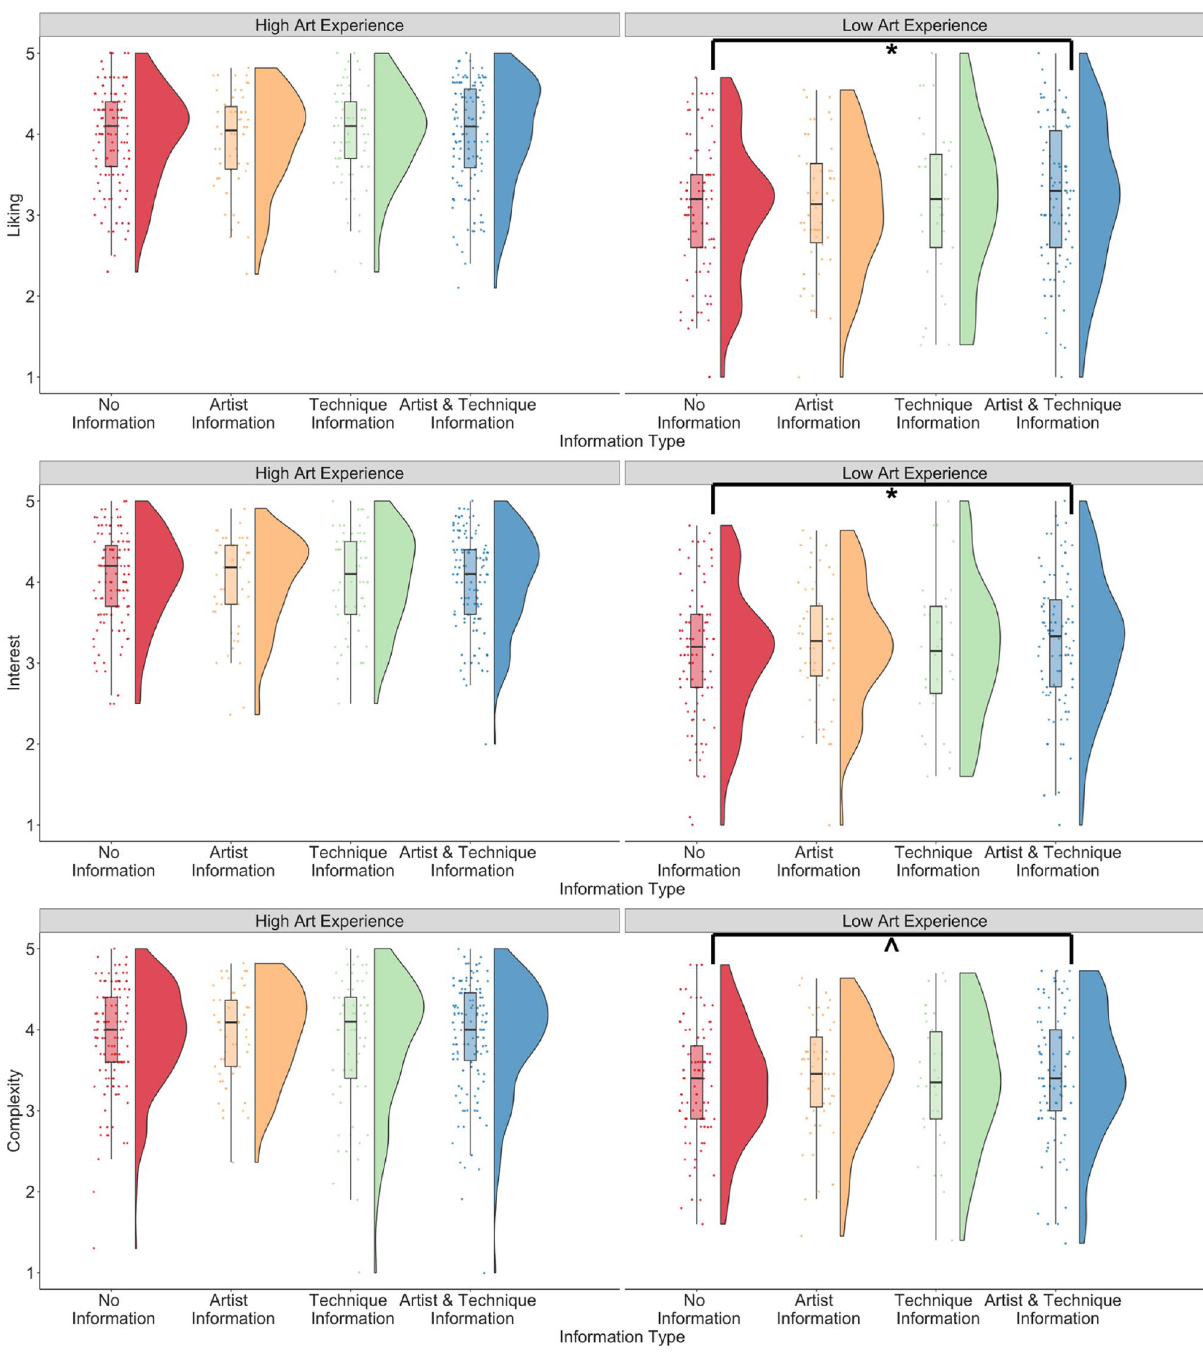
Figure 1. Liking, interest, and complexity ratings when no contextual information was provided to participants, and when information about the artist, information about the technique, and both information about the artist and his technique was provided to participants, split by participants with high and low art experience. *p < .05; ^p =